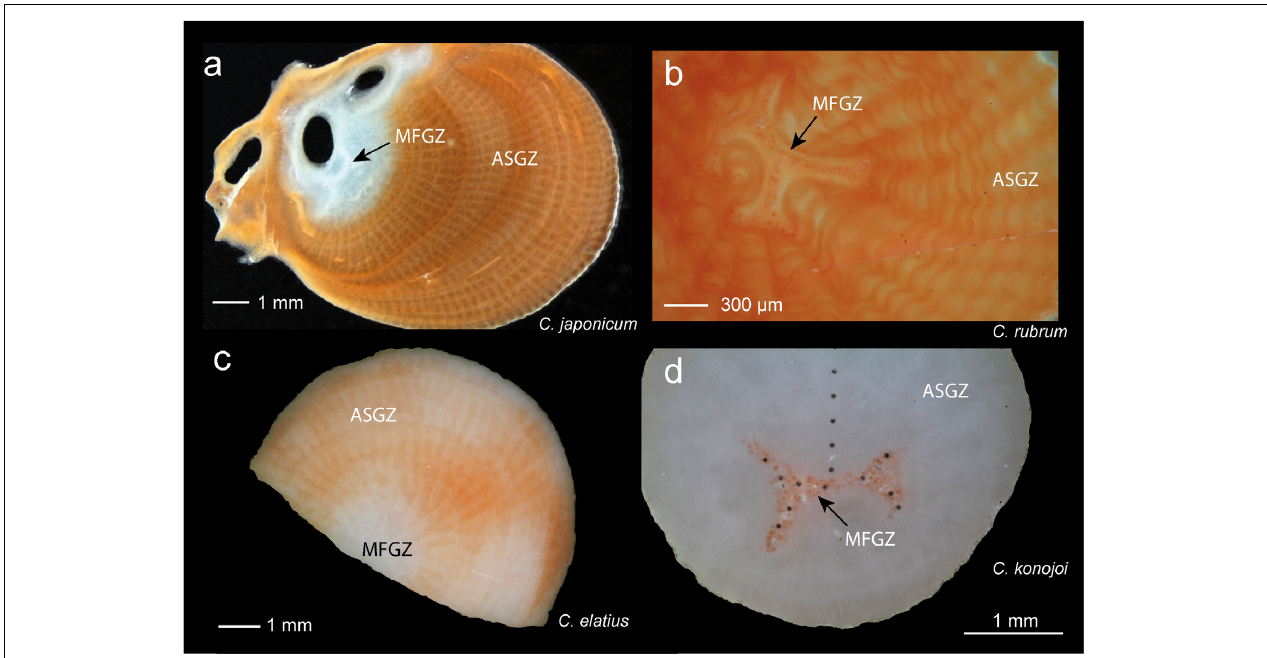
FIGURE 1 | Sections of Corallium skeletons under binocular magnifier. (a) C. japonicum . The medullar zone is located inside the white domain (black arrow), but does not coincide with it. The off-centered annular zone is white around the medullar zone, then red. (b) C. rubrum . Enlargement showing the medullar zone with its characteristic morphology. Sclerites appear as dark units inside the medullar zone. The annular zone with concentric annual layers surrounds the medullar zone. (c) Perpendicular section of C. elatius . The medullar zone located in the inner white zone is not readily identifiable. (d) Section of C. konojoi . The medullar zone can be identified because of the red color of the sclerites. The dark dots correspond to LA-ICPMS spots. MFGZ, medullar fast growing zone; ASGZ, annular slow growing zone.